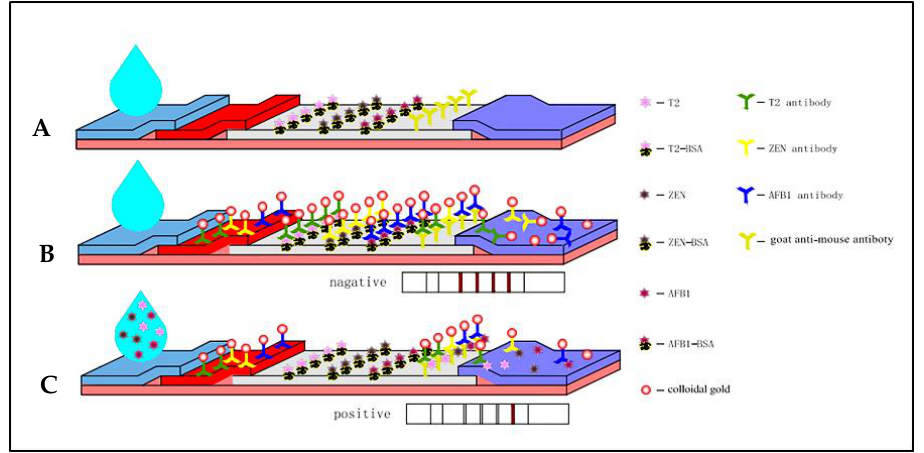
Figure 1. Schematic of the immunochromatographic strip (ICS) for the simultaneous detection of AFB 1 , ZEN, and T-2 ( A ). Negative test ( B ). Positive test ( C ). Here, BSA is bovine serum albumin.